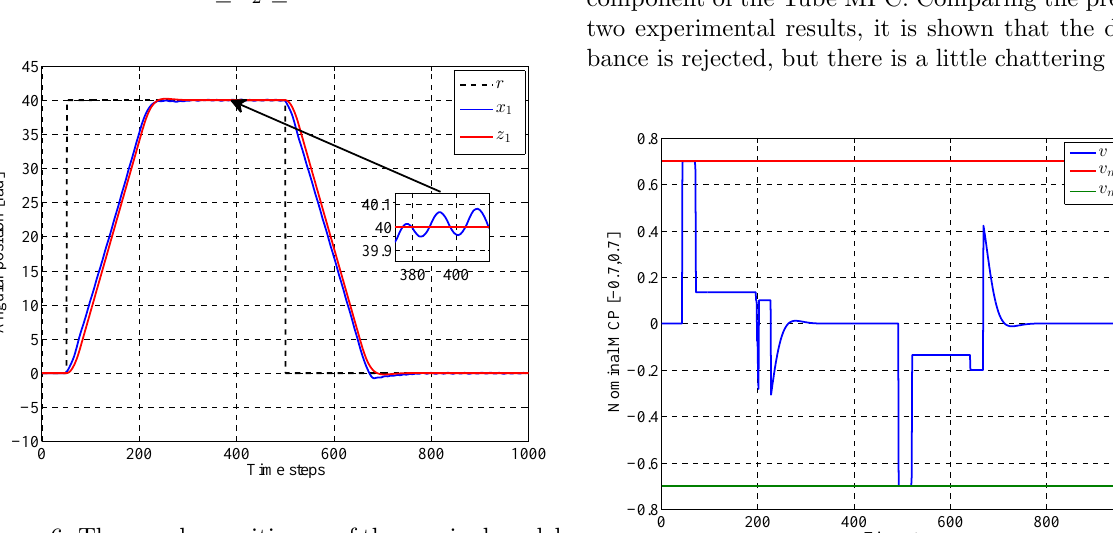
Figure 6: The angular position z 1 of the nominal model for the nominal MPC, and x 1 of the real plant for the proposed control